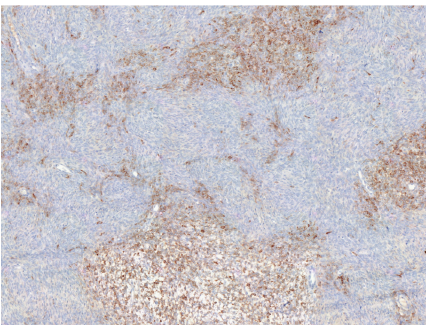
Figure 3: Representative section (hematoxylin and eosin × 40) illustrates cytologically bland fusiform cells arranged in whorls and fascicles alternating with more hypocellular areas with plumped cells with vacuolated cytoplasm.